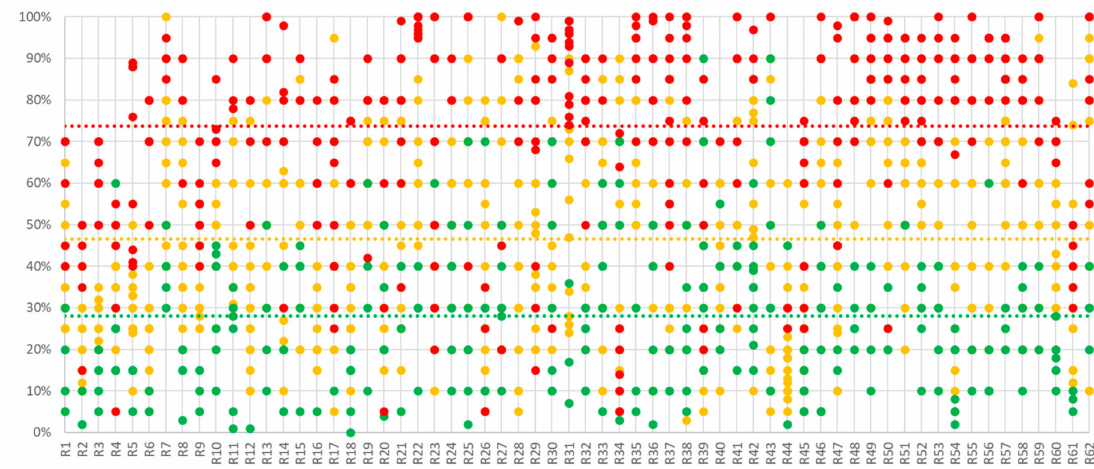
Figure 7. Respondents’ evaluation of L UP of the maps from the Ref-Set coloured by L SE (green representing subloaded maps, red overloaded and yellow maps loaded adequately to their